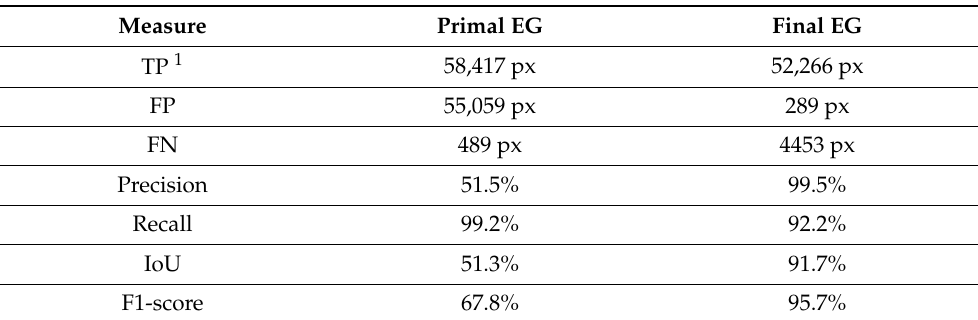
Figure 10. Reference ground truth EG for the sample depicted in Figure 4 manually derived from the original sample image ( a ). Ground truth with identified (blue) and not identified (red) crack paths in the automatic crack processing results depicted in Figure 4f ( b ). Table 1. Quantitative quality measures for primal EG and final EG obtained by EG–EG path compari- son with the ground truth EG (100 µ m overlap tolerance). Definitions and computation details are reported in Supplementary Information